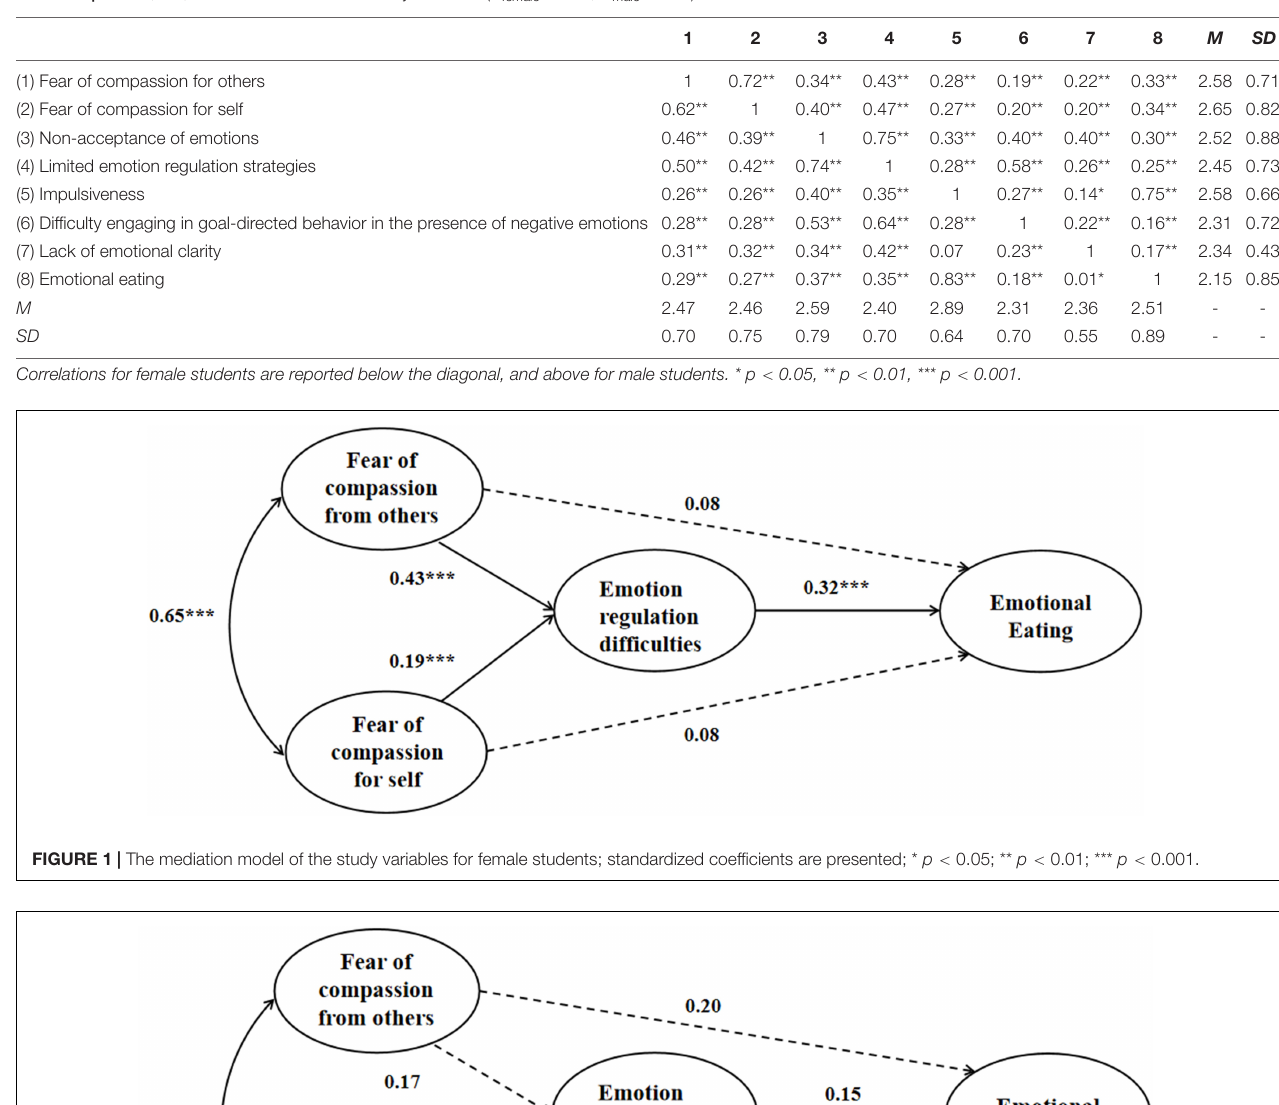
TABLE 1 | Means, SD, and Correlations of the study variables ( N female = 450, N male = 223).